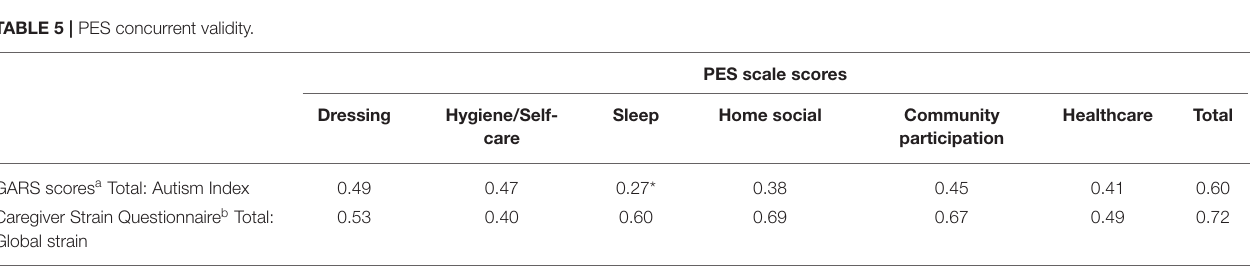
TABLE 5 | PES concurrent